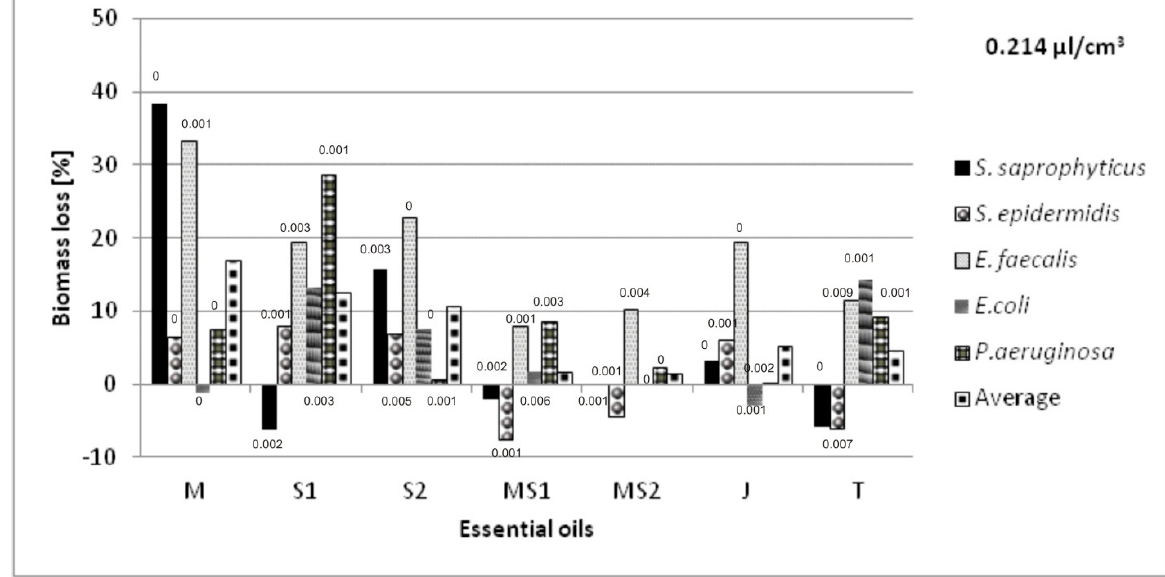
Figure 5. Antimicrobial activity of essential oils in a vapor phase at the oil concentration of 0.214 µL/cm 3 in the atmosphere, where: M— Matricaria chamomilla L., S1— Salvia officinalis L., S2— Salvia lavandulaefolia Vahl., MS1— Matricaria chamomilla L. with Salvia officinalis L., MS2— Matricaria chamomilla L. with Salvia lavandulaefolia Vahl., J— Juniperus communis L., T— Thymus vulgaris L. Results are presented as an average value of three repetitions with ±SD < 0.01 (values of SD placed above the bars); all the results were statistically different ( p < 0.05).